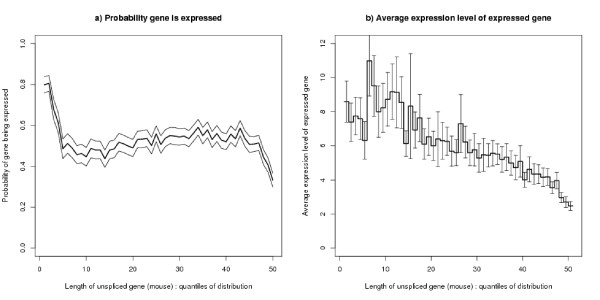
Gene expression by length of gene. The bins for the x-axis are the quantiles of the length distribution for those genes which have expression data. There are 50 bins each containing 2% of the distribution: in each bin n ~ 277. The 10%, 50% and 90% quantiles are gene lengths 1211, 14975 and 91253. 95% confidence limits are shown by the upper and lower lines in (a) and the error bars in (b). a) Probability that a gene is expressed by length of gene: The bulk of the figure shows that on average increasing length of gene implies an increasing probability that the gene is expressed. However, extremely short genes have a high probability of always being expressed and very long genes are less likely to be expressed. b) Average expression level of genes that are expressed by length of gene: The expression level is quoted in arbitrary linear units.